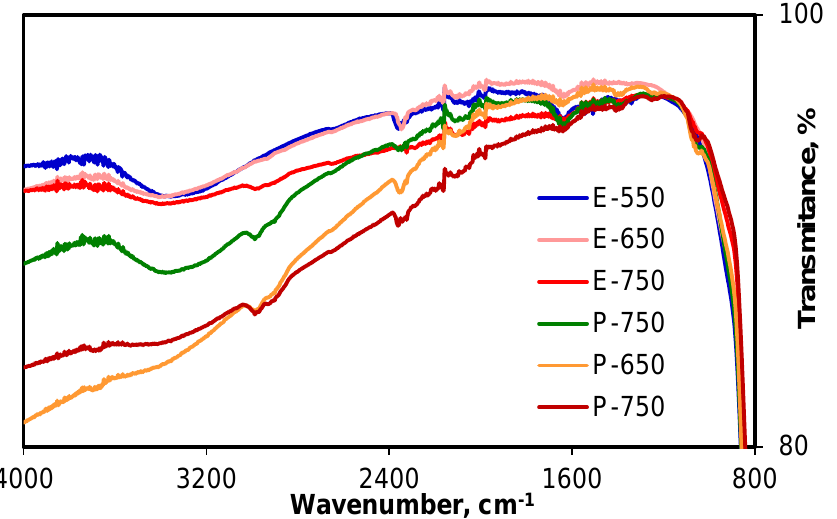
Figure 5. FT-IR spectra of the samples.